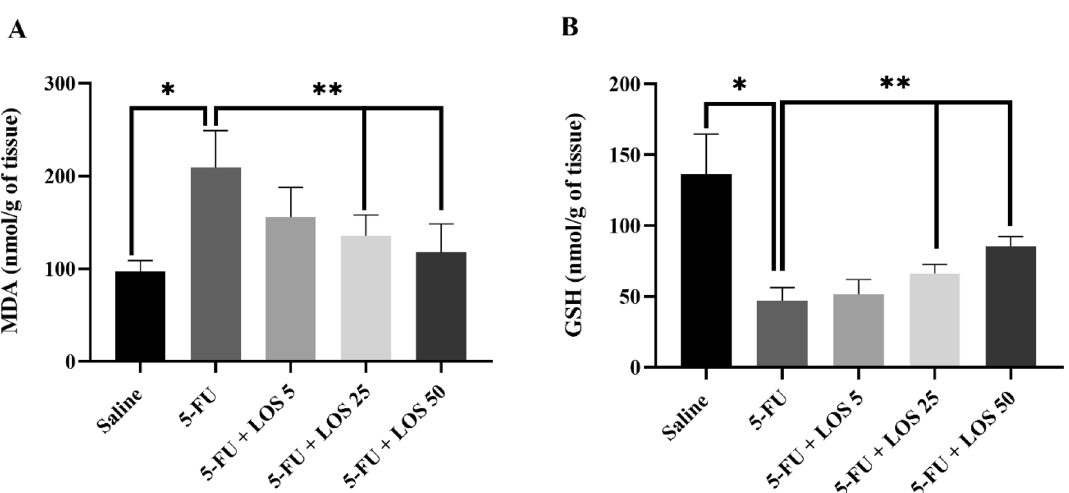
Figure 5. Malondialdehyde (MDA) ( A ) and glutathione (GSH) ( B ) levels in the IM model. The experimental groups saline, 5-FU and losartan are presented in doses of 5, 25 or 50 mg/kg, the values are shown as mean ± SEM. For statistical analysis, ANOVA was used, followed by the Tukey test. *p < 0.01 vs. saline group and **p < 0.01 vs. group